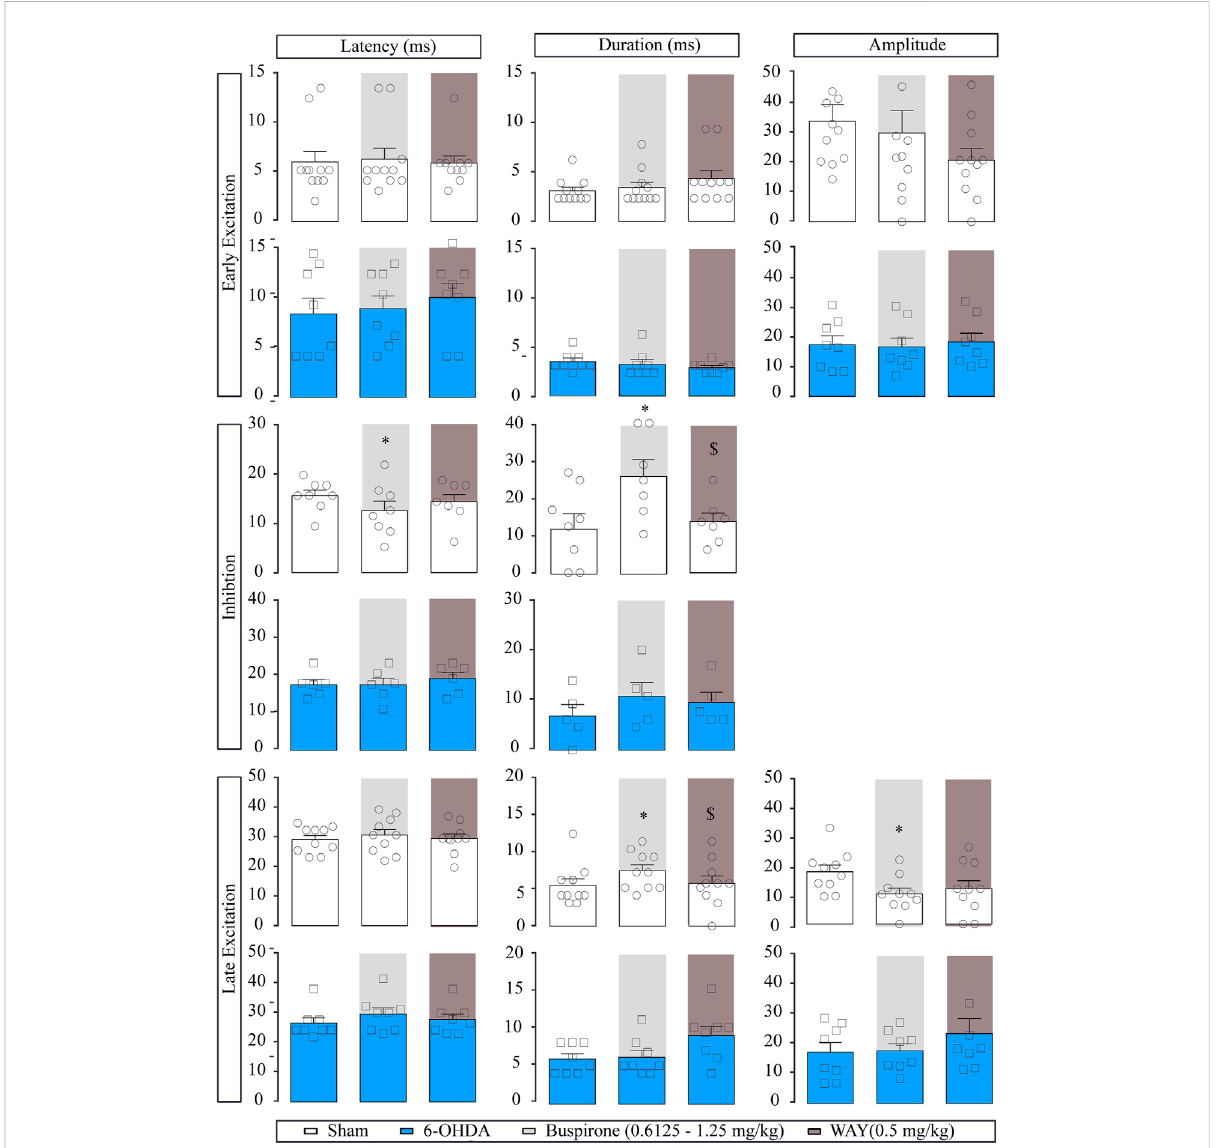
FIGURE 5 Effect of the systemic administration of buspirone on motor cortico-entopeduncular information. Representation of the characteristic parameters related to cortically evoked responses (latency, duration, and amplitude of the responses). The parameters of the early excitatory component are on thetop (sham n = 11, 6-OHDA n =8). The parametersof theinhibitory componentare in themiddle (sham n =7, 6-OHDA n = 6). The parameters of the late excitatory component are on the bottom (sham n = 10,6-OHDA n = 8). Note that buspirone enhanced the duration of inhibition and late excitation in the sham group. Each bar represents the mean ± SEM of n rats. Each dot represents the value from one neuron before and after buspirone (0.6125 mg/kg, i.v.) and WAY-100635 (0.5 mg/kg). * p < 0.05 vs. respective baseline and $ p < 0.05 vs. buspirone (RM two- way ANOVA followed by Bonferroni ’ s post hoc